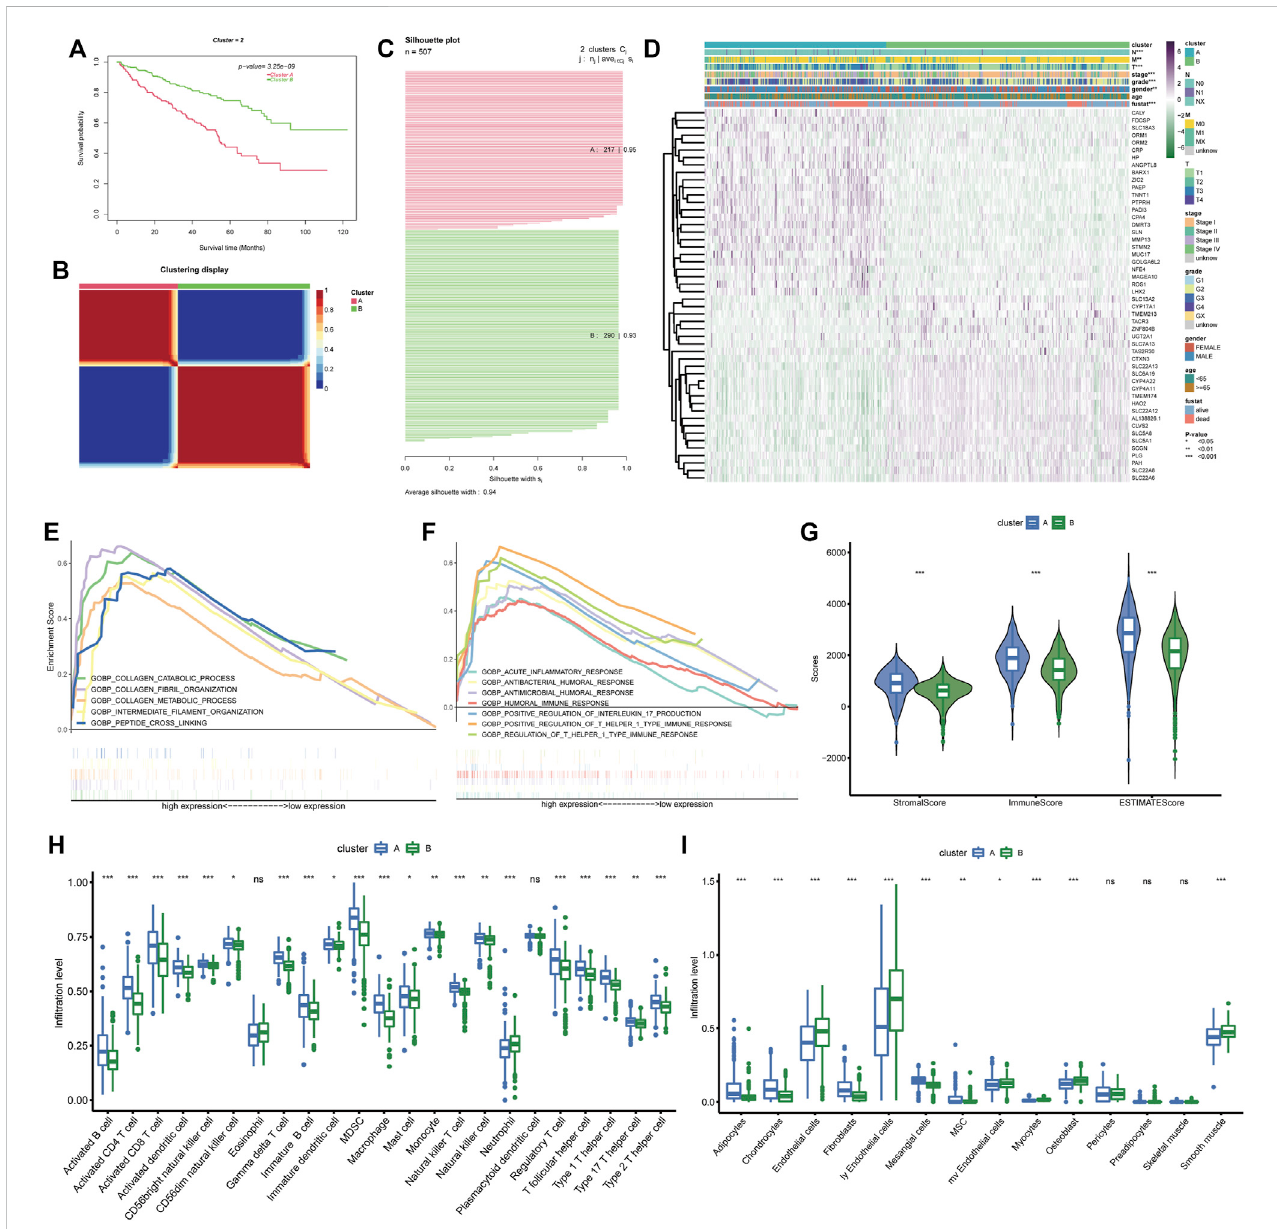
FIGURE 3 BM gene-based classi fi cation of ccRCC patients. (A) Survival analysis of the two ccRCC clusters classi fi ed based on BM genes. (B) The sample similarity matrixplotofthetwoidenti fi edclusters. (C) TheSilhouettewidthplotofthetwoBM-relatedsubtypes. (D) Theheatmapdepicting thedistinctclinicalfeatures and gene expression between cluster (A) and cluster (B) . (E, F) . The biological processes that enriched in cluster (A) . (G) Comparison of the stromal score, immune score and ESTIMATE score between cluster (A) and cluster (B) . (H, I) The different in fi ltration levels of immune cells and stromal cells between the two BM-related